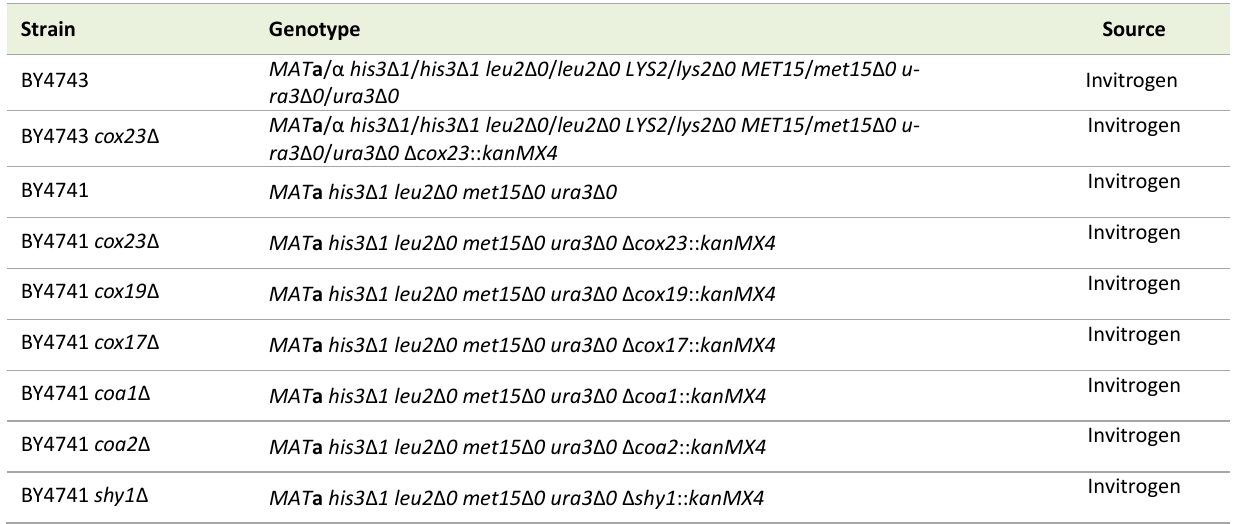
TABLE 1. Genotype and sources of yeast